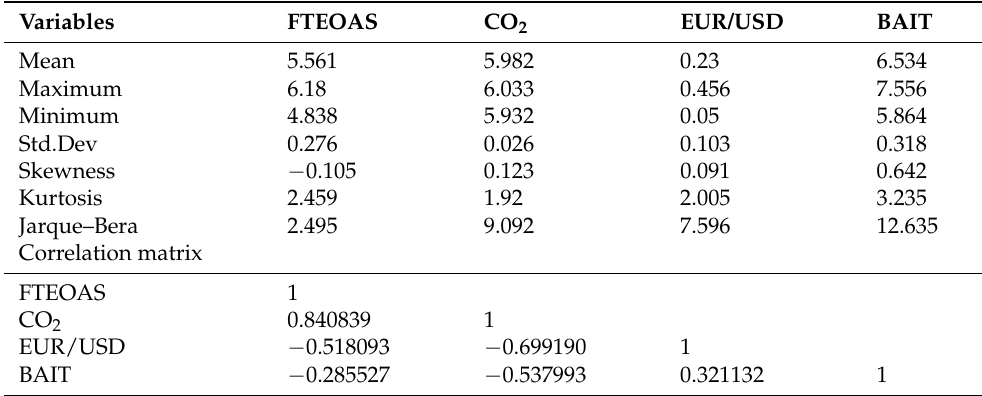
Table 1. Descriptive statistics and correlation matrix.